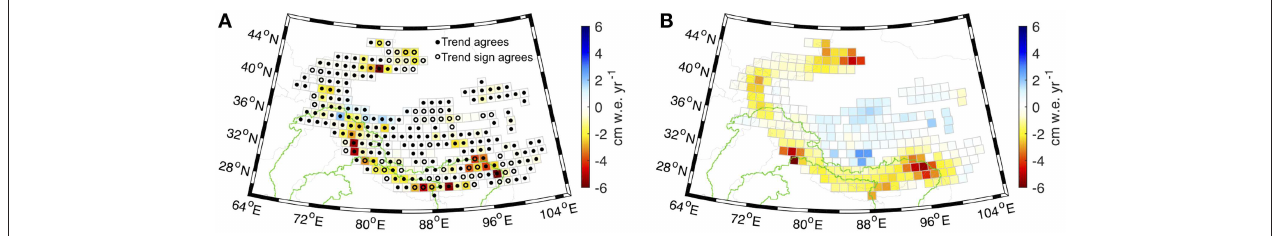
FIGURE 3 | Comparison between mass trends for (A) geodetic glacier mass balance for 2000–2018 and (B) GRACE L1B regression mascons for January 2003–July 2016. The open circles in (A) indicate where the sign of the glacier mass balance trend agrees with the 99% confidence interval and the closed circles indicate where the glacier mass balance trend estimates are within the 99% confidence